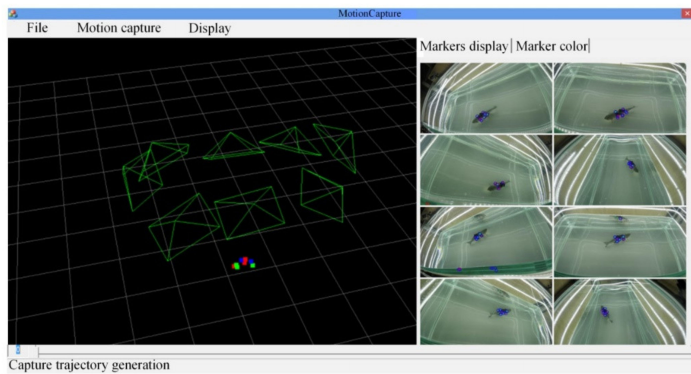
Figure 18. System structure.